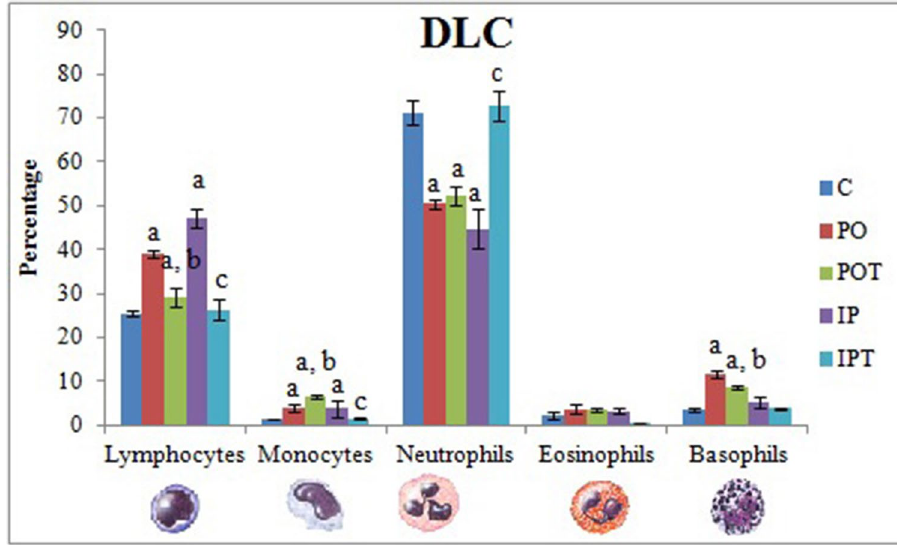
Figure 3. Differential leukocyte count comparing the percentage of WBCs in different groups. The results are shown in mean ± SE (‘a’ symbolizes p < 0.005 control vs experimental groups, ‘b’ symbolizes p < 0.005 experimental vs treatment groups (PO vs POT) and ‘c’ symbolizes p < 0.005 IP vs